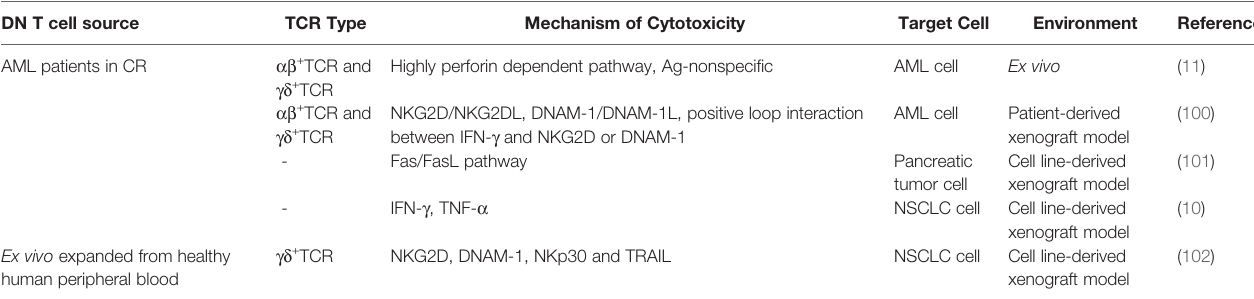
TABLE 3 | Anti-tumor DN T cell in cancer treatment. DN T cell